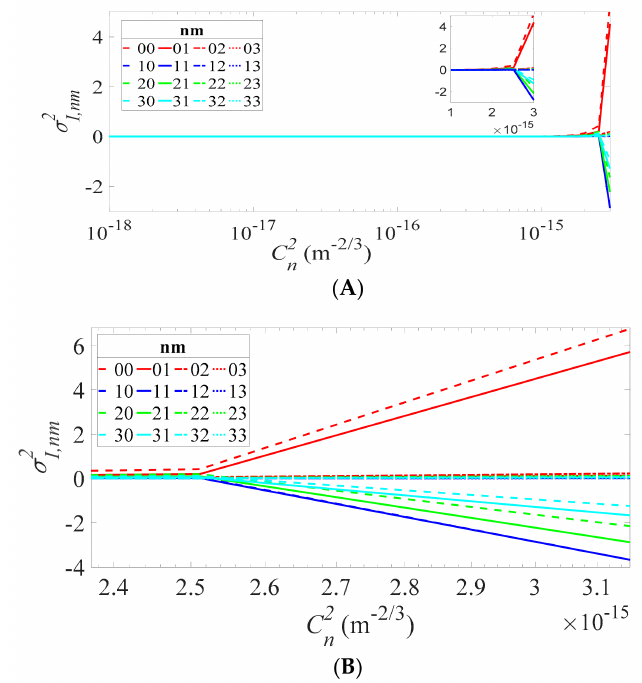
Figure 2. Matrix of the scintillation indices versus ( A ) turbulence structure constant C 2 n ( B ) zoomed values of C 2 n